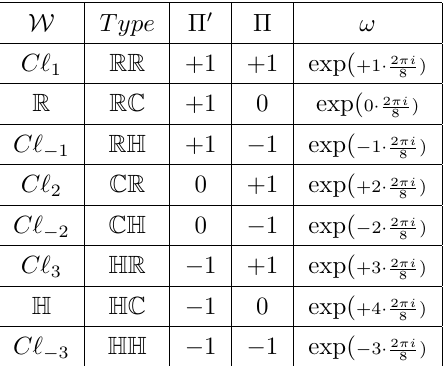
Table 4 . The Dyson Types having real central graded commutants matched with their Frobenius- Schur